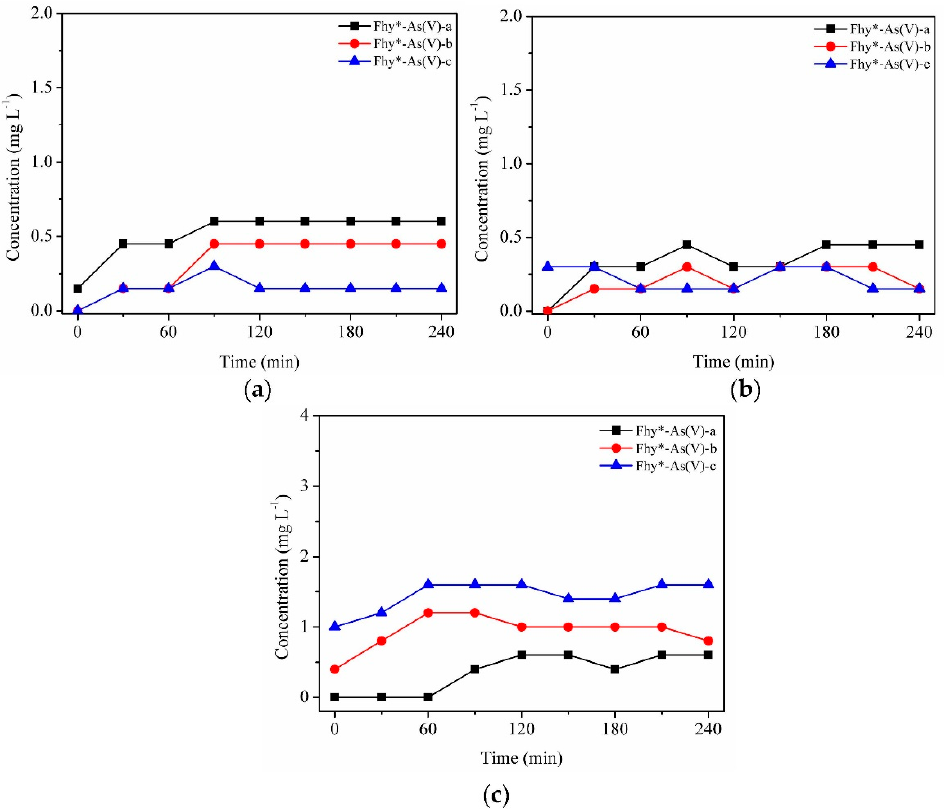
Figure 6. Dissolution kinetics under UV illumination with suspensions of 0.1 g L − 1 Fhy*-As(V) at pH 3.0. Dissolved TFe ( a ), dissolved Fe(II) ( b ), and As(V) ( c ) were measured.